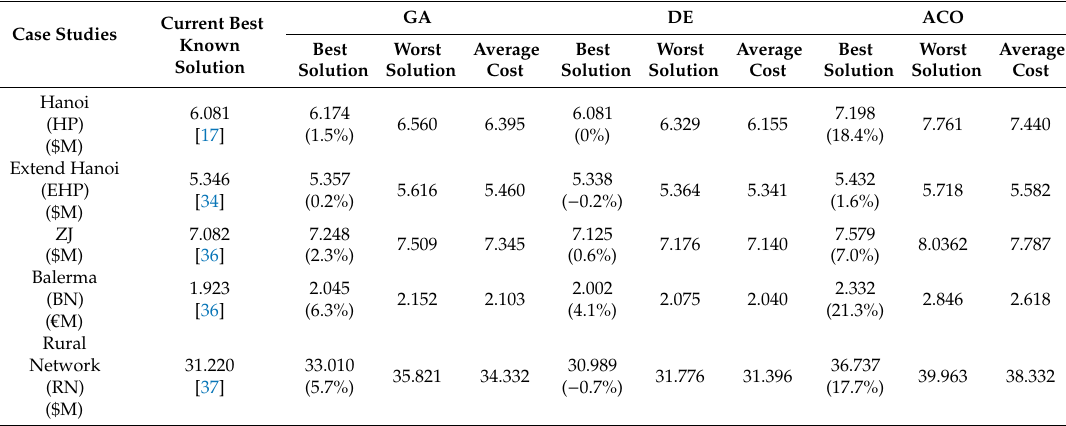
Table 3. Solution statistics of the three algorithms, where the percentage indicates the difference between the best solutions found by the three algorithms in this study and the current best known solutions in literature.